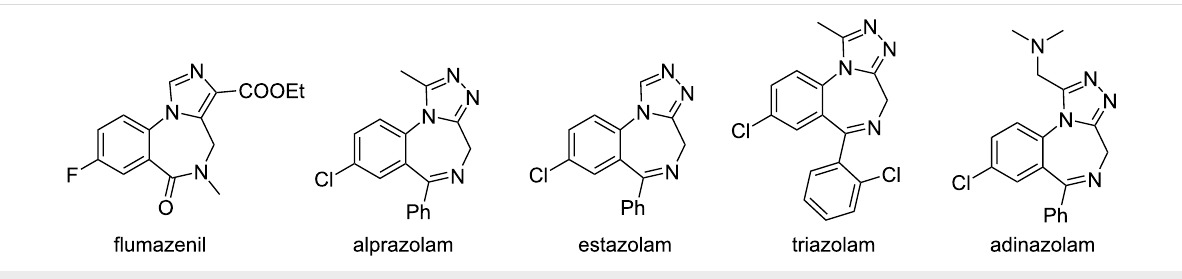
Figure 1: Benzodiazepine-based azolo-containing drugs.